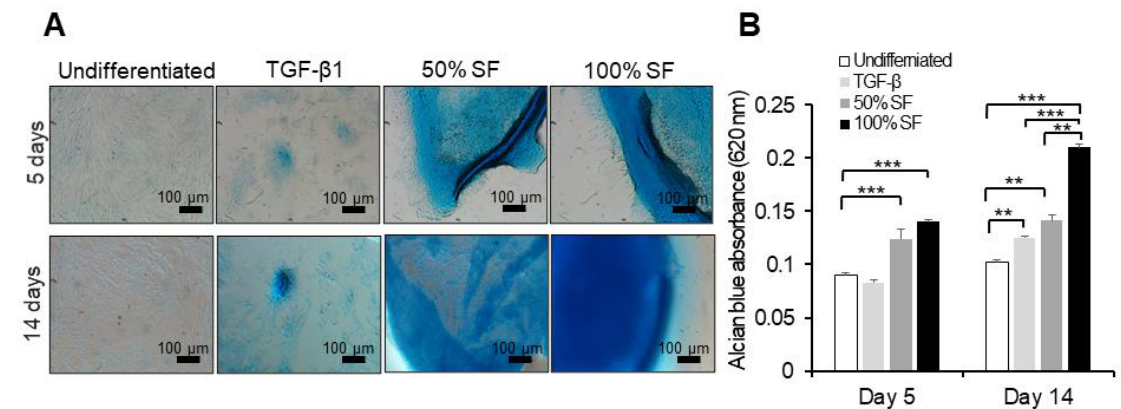
Figure 5. Evaluation of chondrogenic differentiation in the presence of allogeneic synovial fluid. BMMSCs were cultivated as monolayer in the presence of 50% and 100% of allogeneic synovial fluid or chondrogenic differentiation medium containing TGF-β1 for up to 14 days. The MSCs were stained using Alcian blue. ( A ) Photomicrographs of MSCs at days 5 and 14 show cartilage glycosaminoglycans (blue) indicative for chondrogenic differentiation. ( B ) Total glycosaminoglycan (GAG) production in the monolayer for different time points. ** p < 0.01, *** p < 0.001. Quantitative data are expressed as mean ± SD ( n = 3) and were analyzed using one-way ANOVA, with Tukey’s comparison test as a posttest. p < 0.05 was considered statistically significant. One representative experiment is presented from three different experiments using cells from different donors ( n = 3), each performed in triplicate.